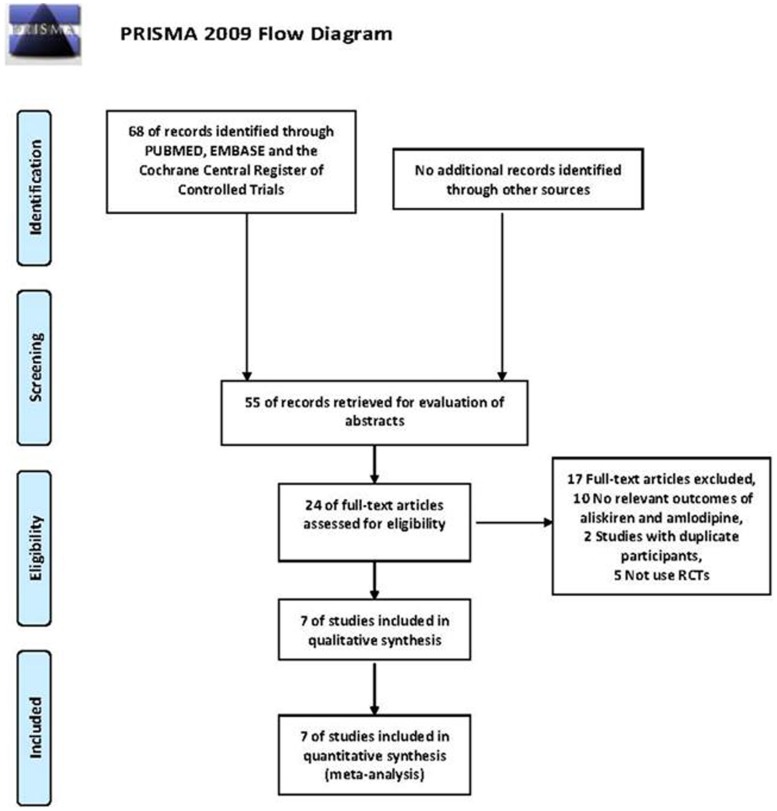
PRISMA flow diagram.